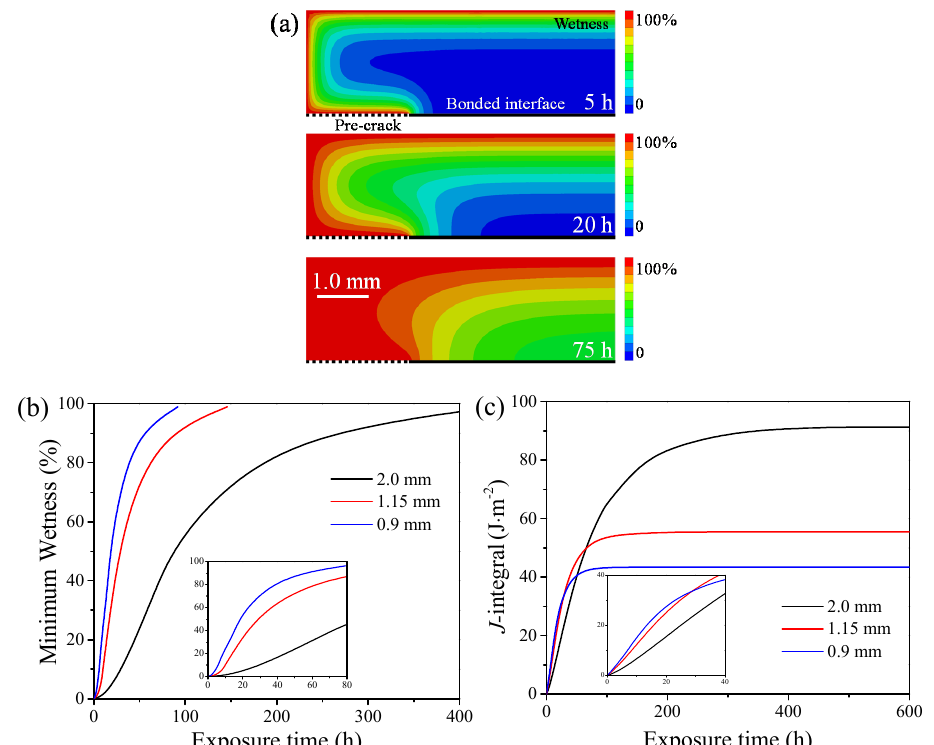
Coatings 2019 , 9 , x FOR PEER REVIEW 11 of 16 whole interface. In Figure 12b, the wetness contours and deformation for 90, 91 and 100 h exposures are displayed, showing that the coatings have experienced obvious deformations compared with their original shapes (see dashed lines). Figure 11. ( a ) Transient moisture wetness distribution in a 2 mm thick coating. ( b ) Relationship between minimum wetness value and exposure time in epoxy layer with different coating thickness. ( c ) Interfacial J i values as a function of exposure time for non-propagating cracks.